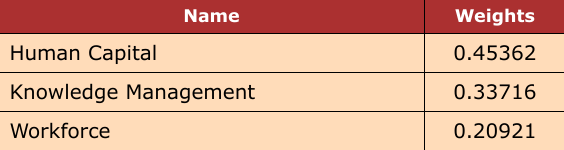
Table 7. Social Performance Indicators Priorities